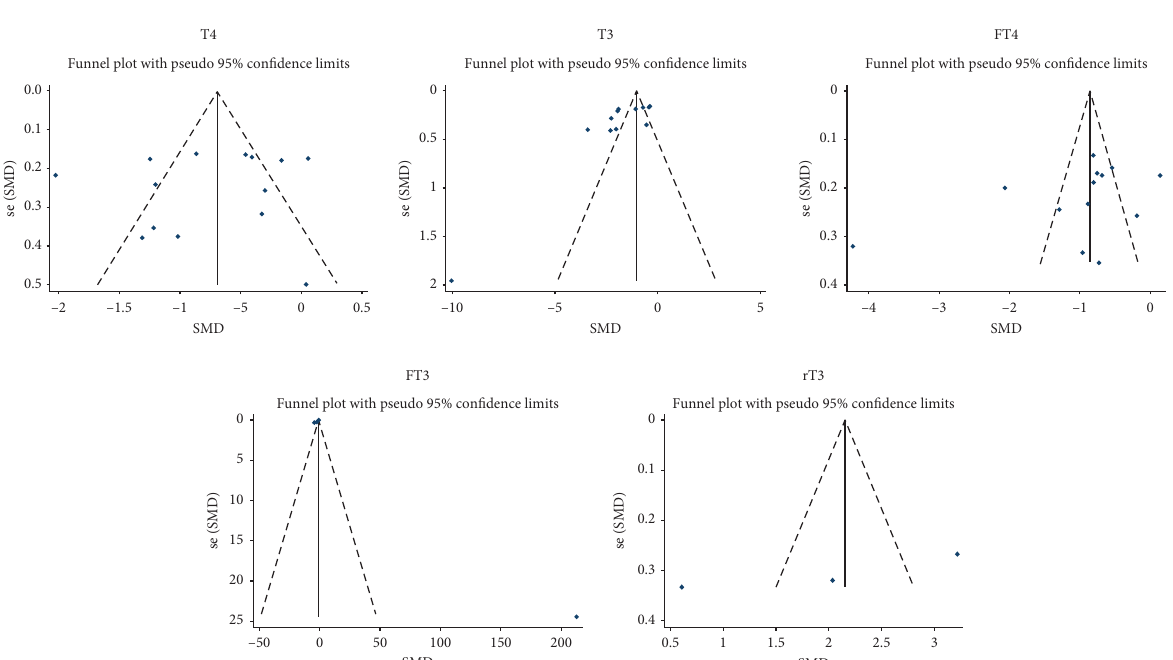
Figure 6: Funnel plot of T4, T3, FT4, FT3, and rT3 compared with patients with DKA before and after